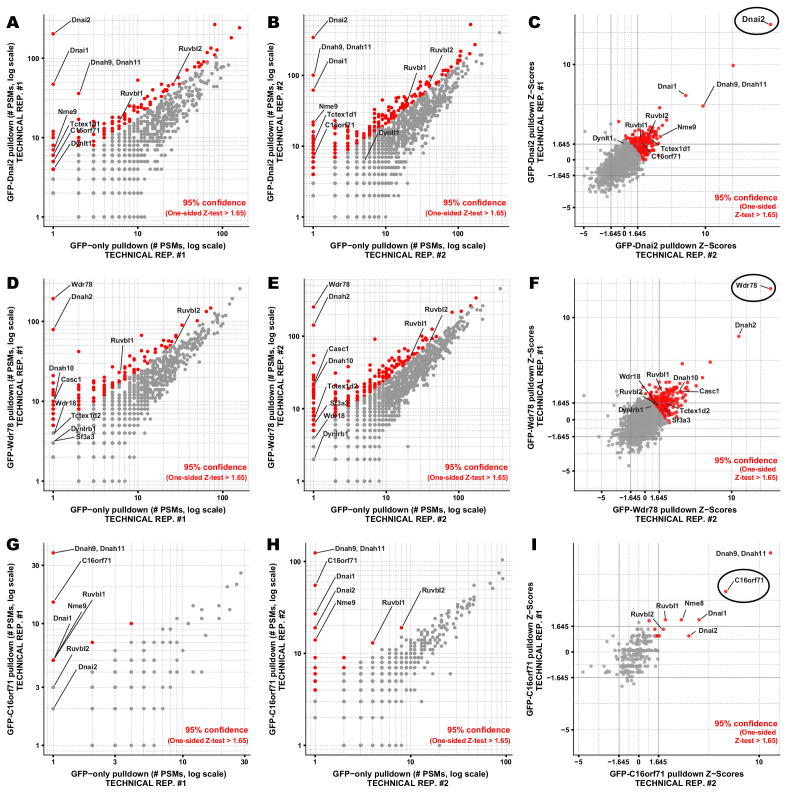
Proteins co-precipitating with Dnai2, Wdr78, and C16orf71 by APMS.Interaction partners of (A-C) Dnai2, (D-F) Wdr78, and (G-I) C16orf71 were identified based on their enrichment in APMS of the GFP-tagged bait proteins (vertical axes, panels A-B, D-E, G-H) relative to APMS of the untagged GFP controls (horizontal axes, panels A-B, D-E, G-H). A pseudocount of 1 PSM was added to each protein for visualization on a log-log plot (panels A-B, D-E, G-H). For visualization purposes, each protein was colored according to a 95% confidence threshold using a one-sided Z-test (see Materials and methods). We observed reasonable concordance between technical replicates, evident in comparisons of the measured Z-scores for proteins co-precipitating with (C) Dnai2, (F) Wdr78, and (I) C16orf71. Baits are circled in C, F, I. A joint Z-score was calculated for each protein observed across a pair of technical replicates by summing the Z-score for each protein in each replicate and dividing by the square root of N replicates (N = 2). Multiple-hypothesis corrected p-values derived from these joint Z-scores are provided in the corresponding Suppl. Tables.